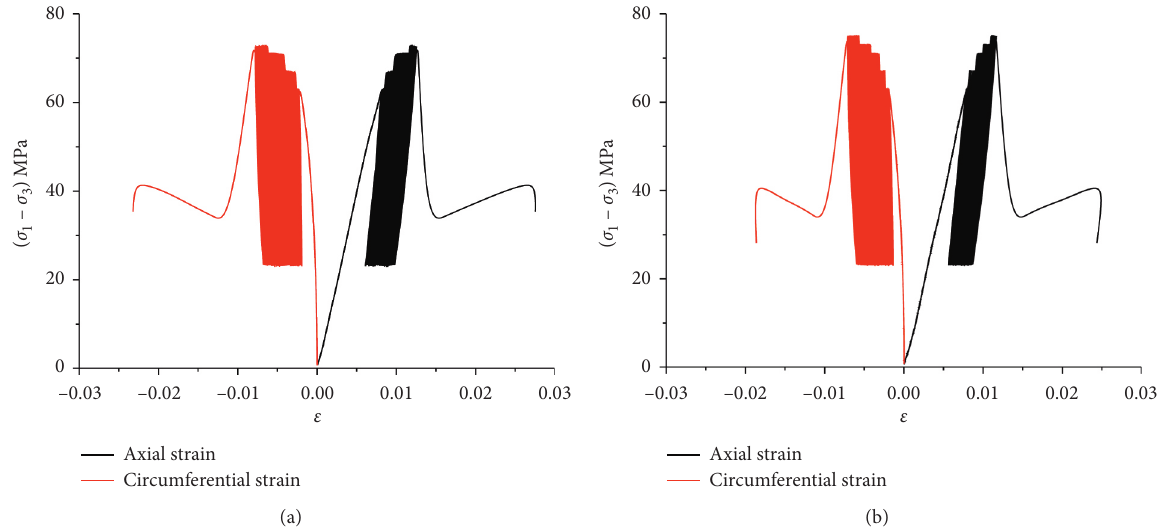
Figure 6: Stress-strain curves of limestone specimens in the triaxial cyclic loading test. (a) Cyclic loading with a frequency of 0.25Hz. (b) Cyclic loading with a frequency of 0.5Hz. Table 3: Fragment classification and measurement procedures.